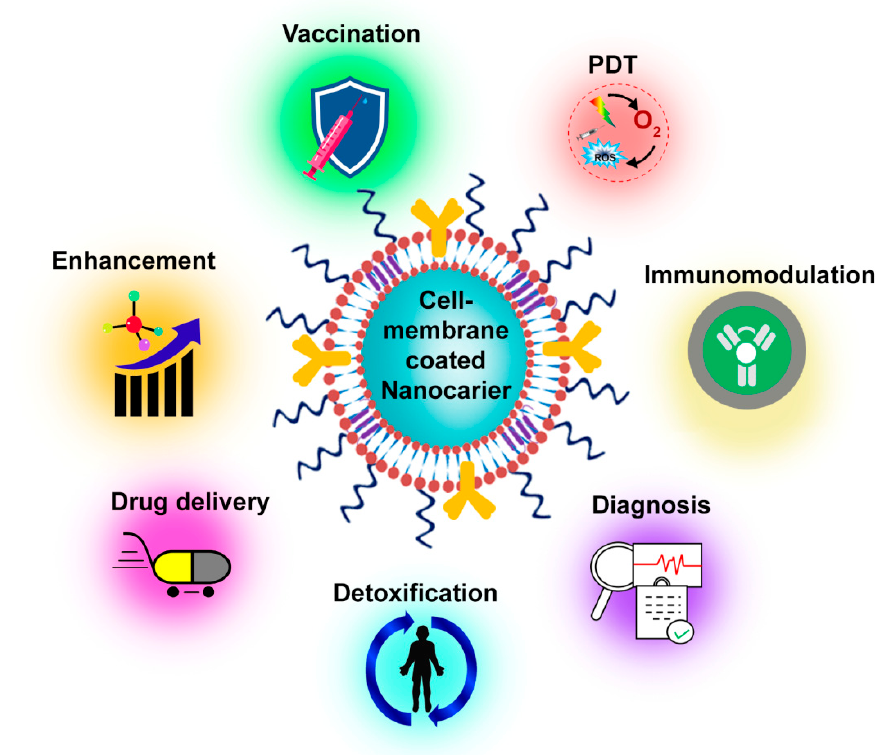
Figure 2. Biomedical applications of